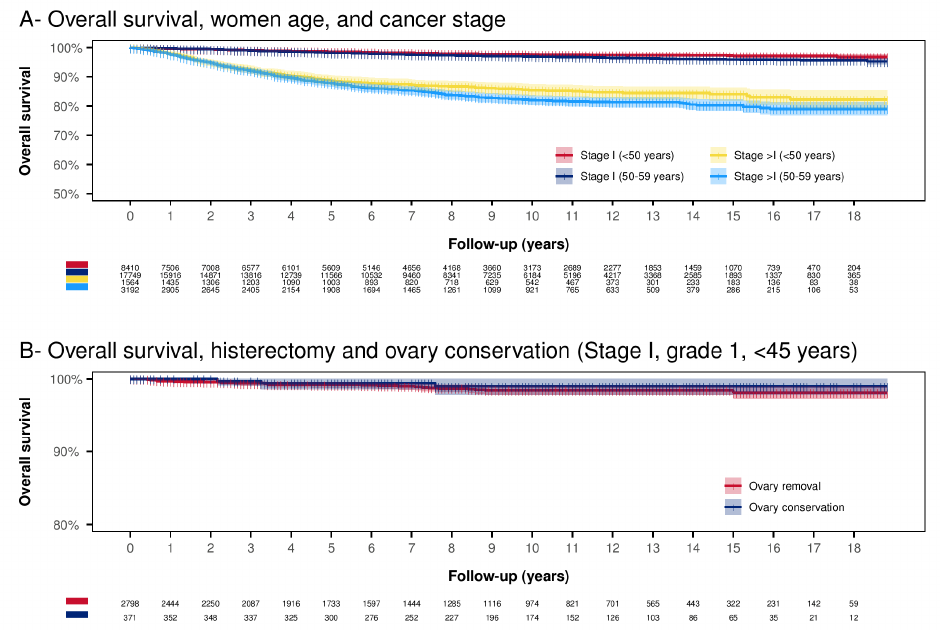
Figure 3. Kaplan–Meier analysis. Panel ( A ) Overall survival according to age category and stage. The Log-rank test results statistically significant for all the paired comparisons. Almost all the differences have p < 0.001, except two cases: Stage I (<50 years) vs. Stage I (50–59 years) ( p = 0.001) and Stage >I (<50 years) vs. Stage >I (50–59 years) ( p = 0.038). Panel ( B ) Overall survival according to ovary conservation in stage I, tumor grading G1 below 45 years of age (uterus conservation is excluded). The Log-rank test results are not significant ( p = 0.436). Table 2. Univariate and multivariate Cox regression overall survival